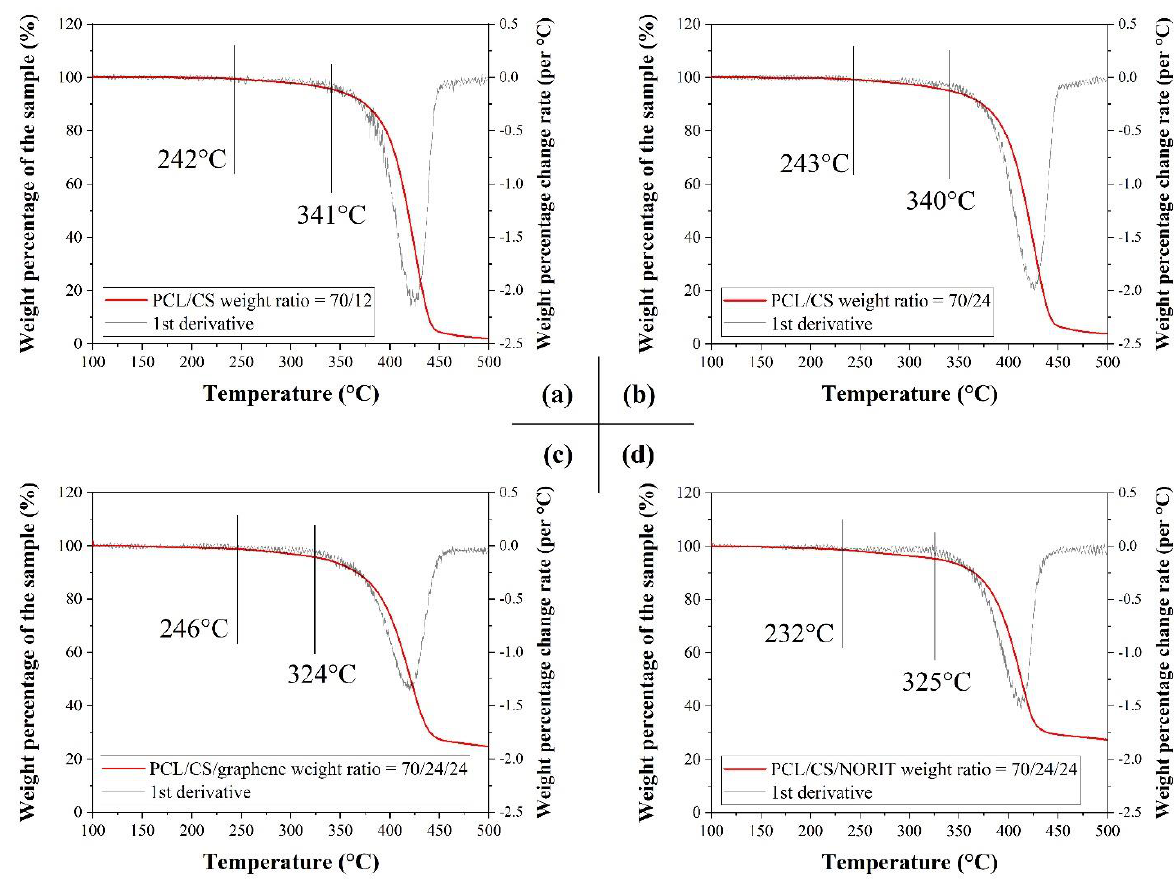
Figure 7. The TGA curves of the PCL/CS porous monoliths: ( a ) G − CS12; ( b ) G − CS24; ( c ) G − CS24 − G; ( d ) G − CS24 − N.